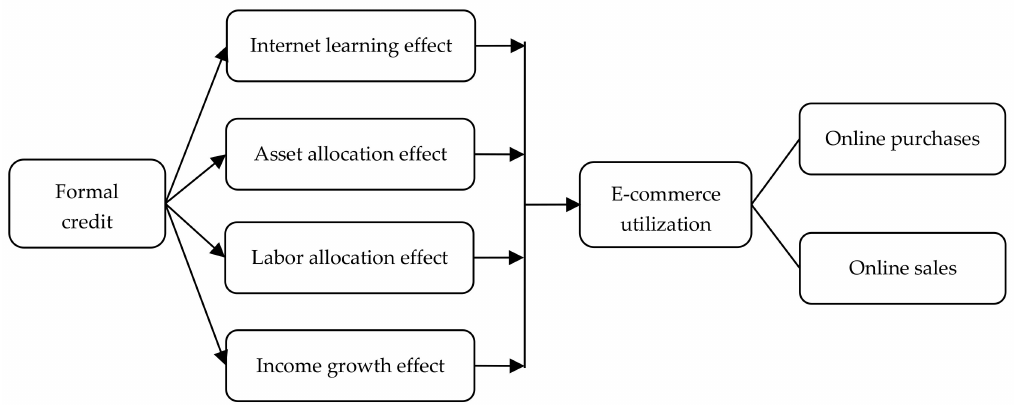
Figure 1. Conceptual framework showing that four impact channels of formal credit affecting e-commerce